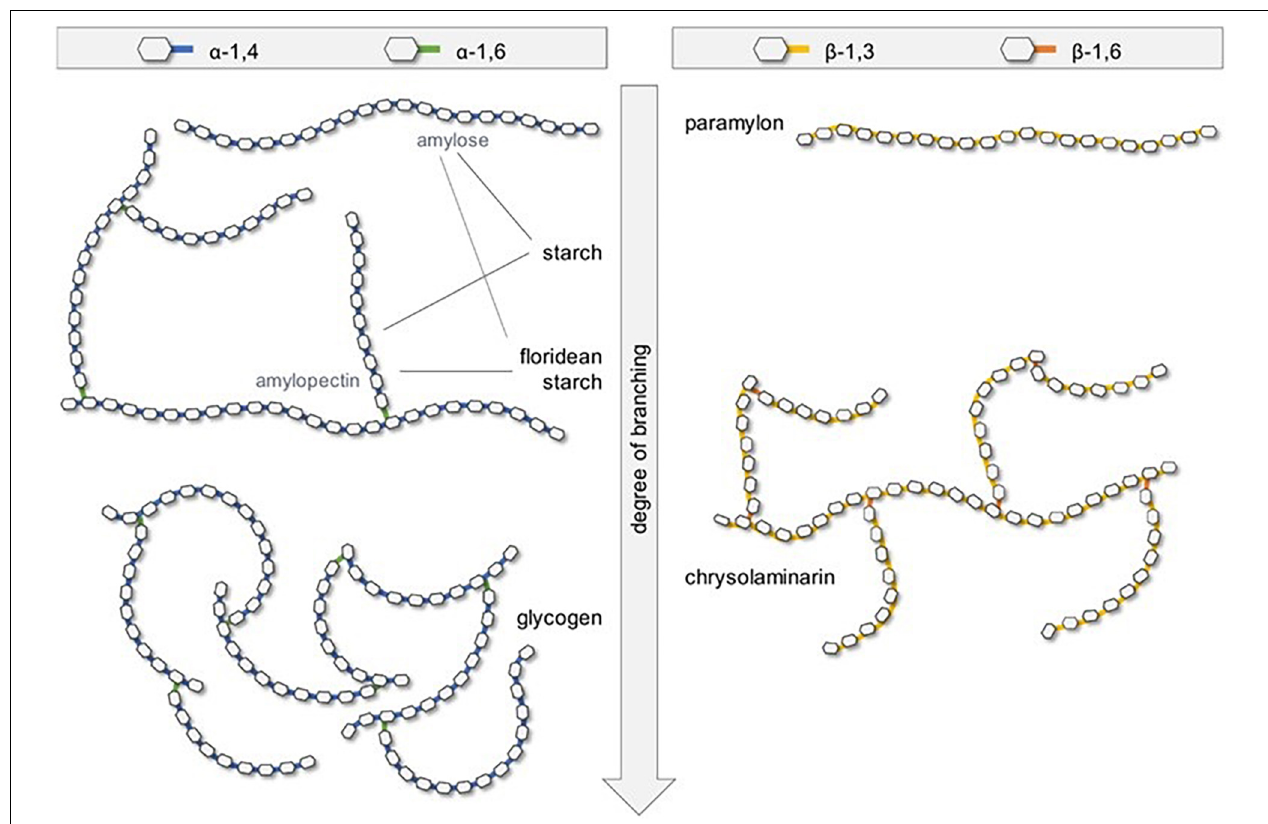
FIGURE 5 | Schematic representation of the five common storage types of microalgae polysaccharides (121) (Copyright permission: